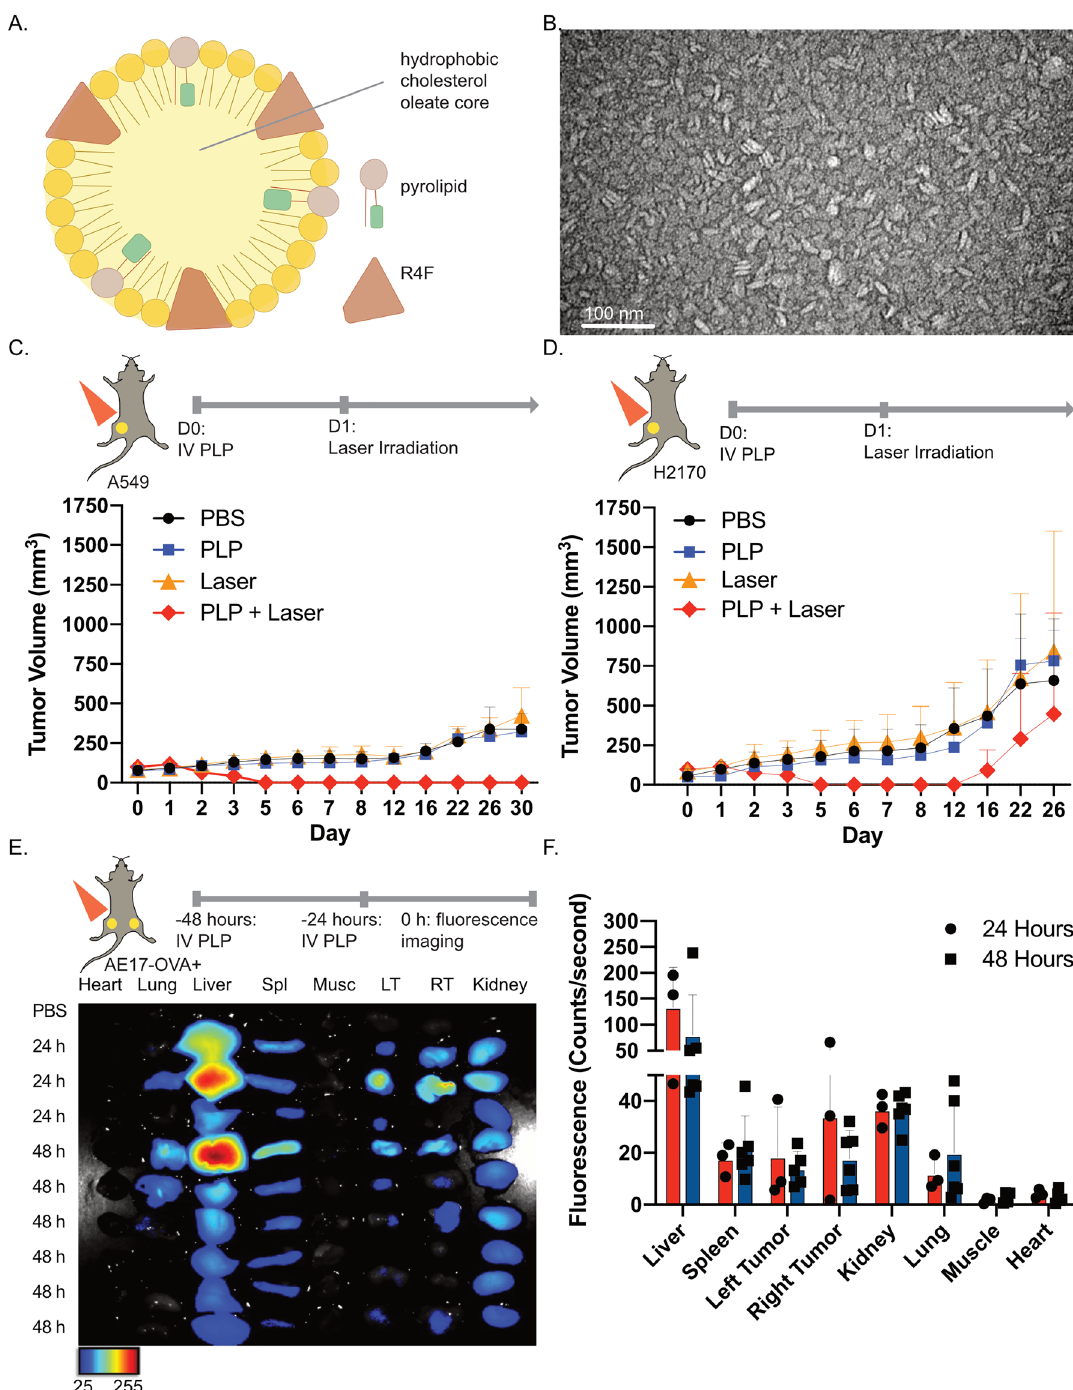
Figure 1: Porphyrin-lipoprotein (PLP) can be an effective photosensitizer for lung tumor models. (A) Schematic of PLP, the photosensitizer used for photodynamic therapy. (B) Transmission electron microscopy (TEM) image of PLP at 200 000 × magni fi cation. (C) Assessment of tumor burden in subcutaneous A549 tumors in nude mice, after treatment with phosphate- bufferedsolution(PBS),PLP(4mg/kg),laserirradiation,orphotodynmaictherapy(PDT)(PLP + laser). n =3pergroup.(D)Assessmentoftumor burden in subcutaneous H2170 tumors in nude mice, after treatment with PBS, PLP (4 mg/kg), laser irradiation, or PDT (PLP + laser). n = 2 per group. Mice received light irradiation with a 671 nm laser at a light dose of 100 J/cm 2 at 24 h postinjection of PLP. (E) Ex vivo fl uorescence imagingofheart,lung,spleen(Spl),muscle(Musc),left(LT)andright(RT)tumors,andkidneysdissectedfrommicebearingdualsubcutaneous AE17-OVA + tumors. Mice received intravenous injections of PBS ( n = 1), or PLP (4 mg/kg) at 24 h ( n = 3) or 48 h ( n = 6) prior to imaging. (F) Quanti fi cation of the fl uorescence signal in various organs. Data are mean ± standard